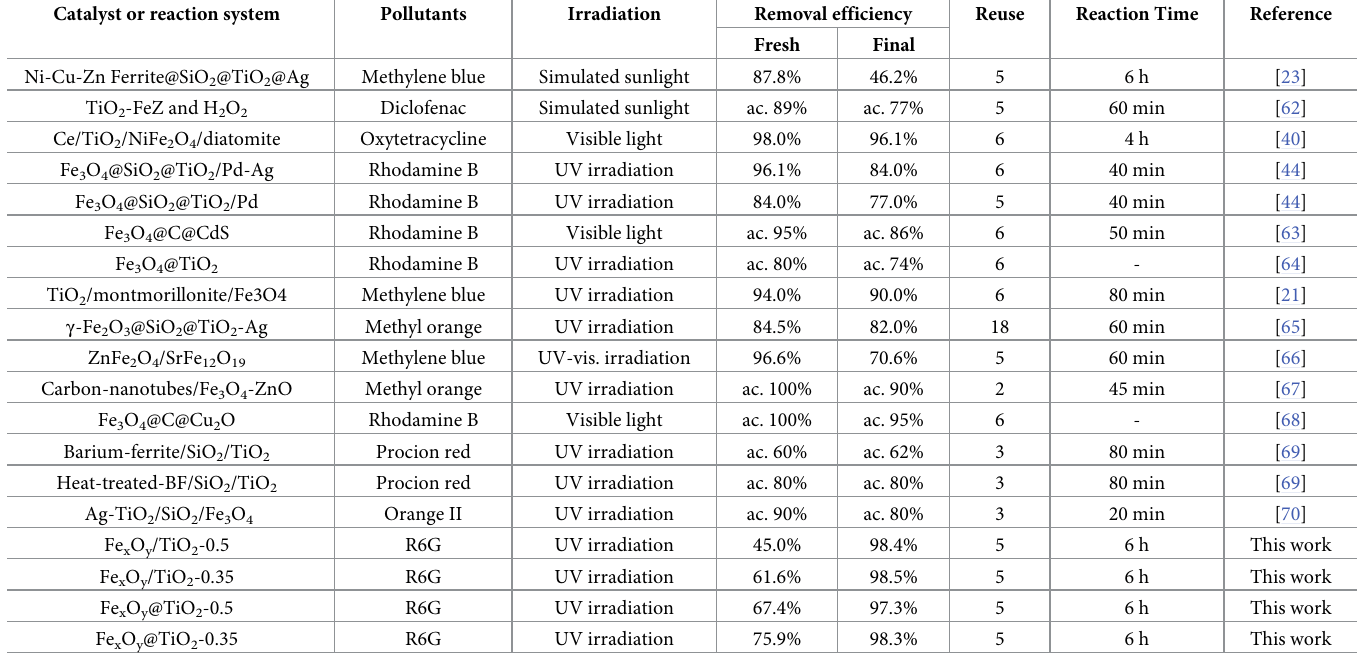
Table 3. Photocatalytic performance of magnetic photocatalysts after